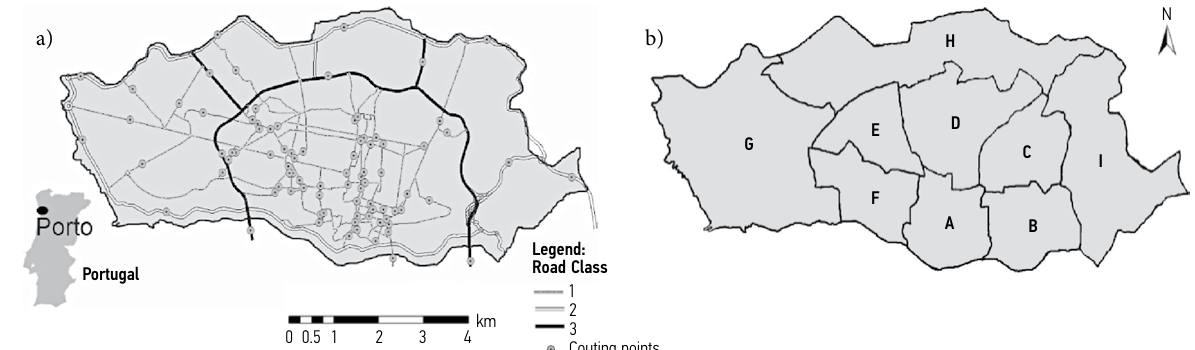
Fig. 4. Administrative limits of the Porto Urban Area and road network considered in the study (type 1 – urban streets, type 2 – interurban roads, type 3 – highways) (a); sectors limits considered in the O/D matrix